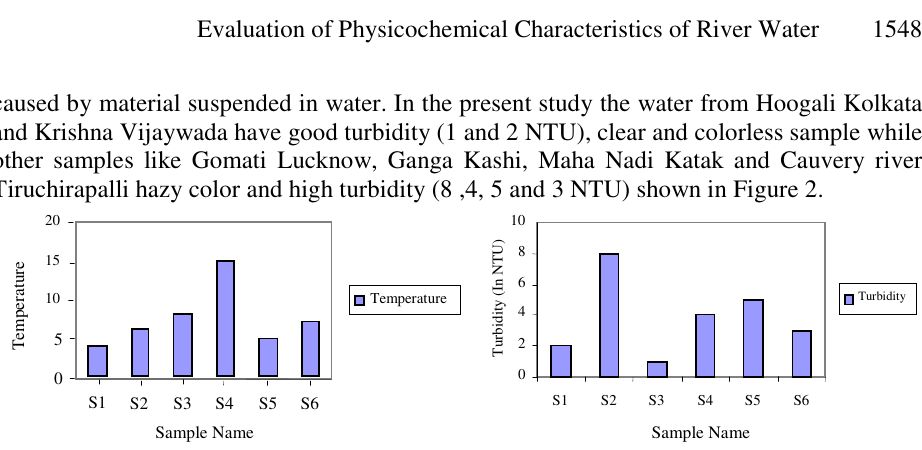
Figure 1. Temperature in various sample Figure 2. Turbidity in various sample